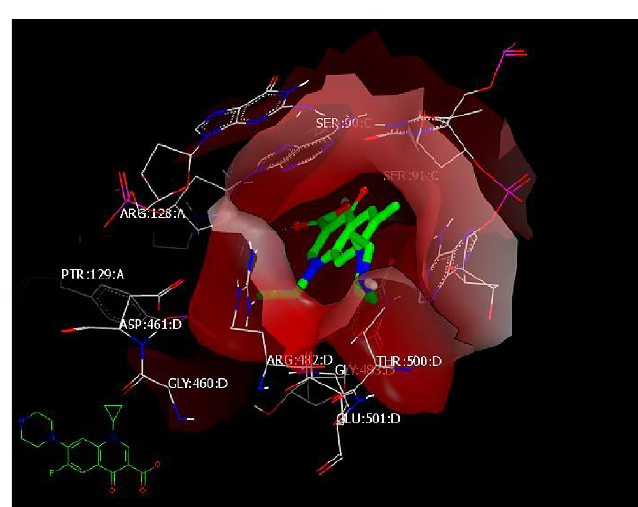
Figure 6. Visual representation of compounds 61c , 61o , and 61l docked with 5BTC, showing no hydrogen bond interaction, as shown by Vida. Image adapted from Elshaier et al. [65]. Regarding the molecular docking with Gyrase B (PDB ID 4URM), compound 61c (consensus score: 24) showed an HB interaction with ASN 145:A through the sulfur atom of the thiobarbiturate ring and overlay with 61a , 61d , and 61f with the same HB. However, 61a showed extra HB with GLN 196:A through the N of pyrazole (Figure 7).